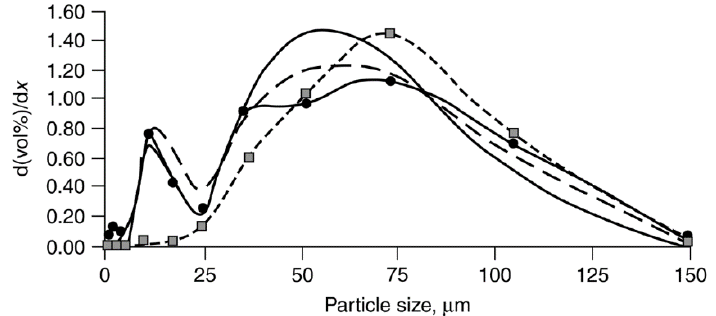
Figure 30. Particle size distributions of Co/SiO 2 catalyst. Adapted from [178]. ––––– Ultrasound 250 W (>10 μm);- - - jet cup L/min (>10 μm); —●— Co/SiO 2 after SBCR; Co/SiO 2